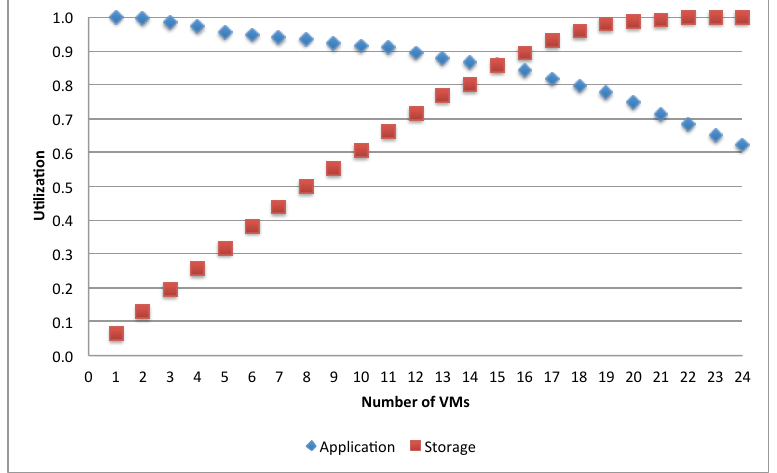
Figure 14. Bottleneck switching with asynchronous